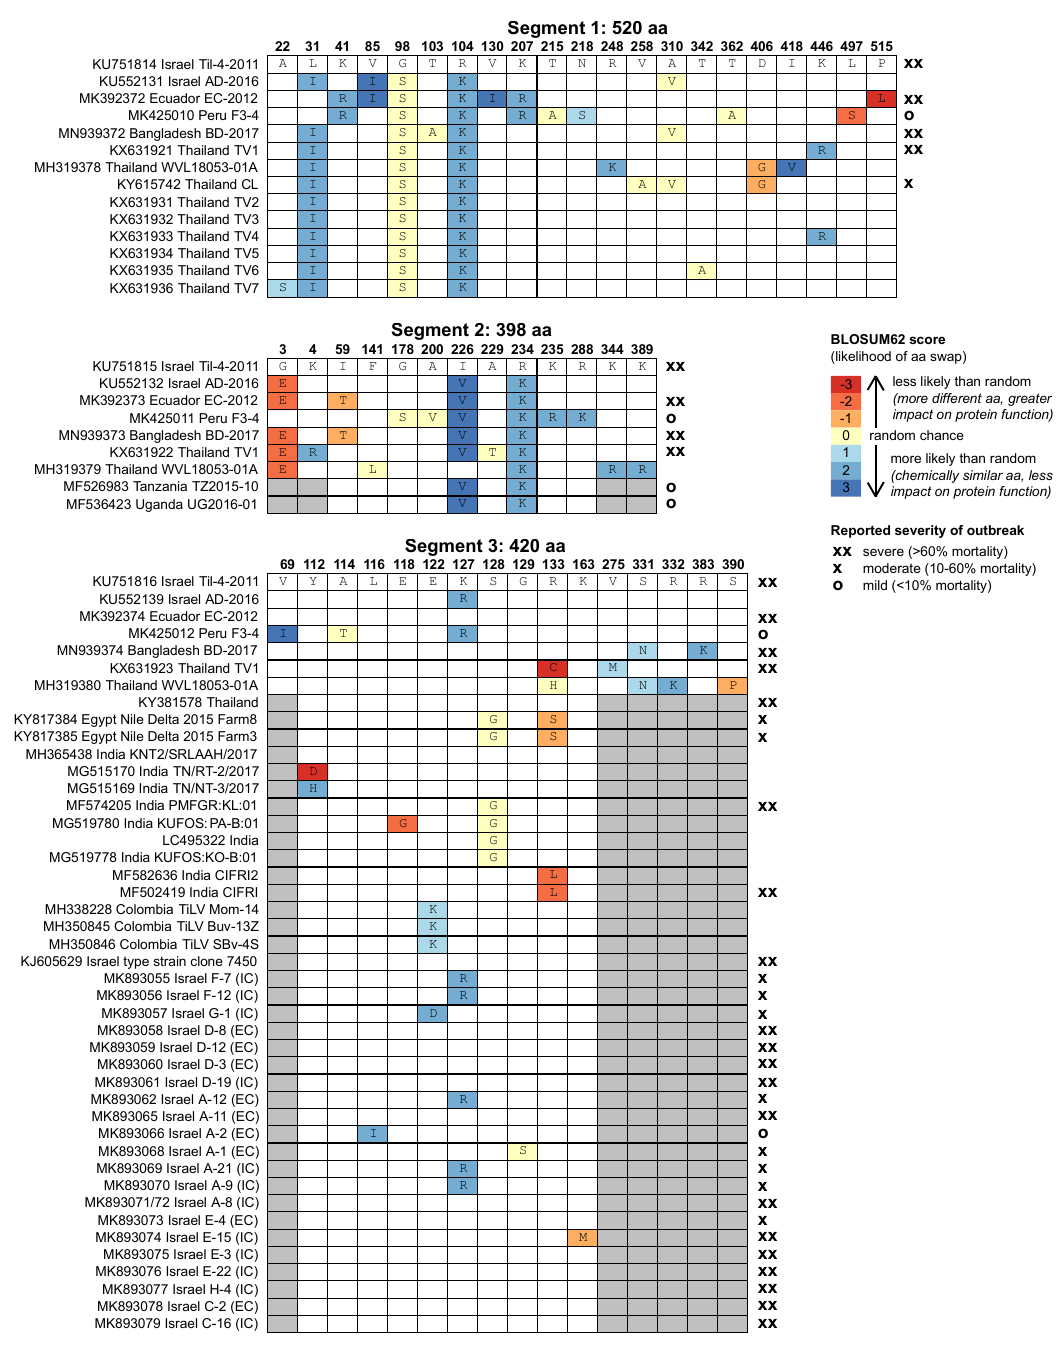
BLOSUM62 score (likelihood of aa swap)